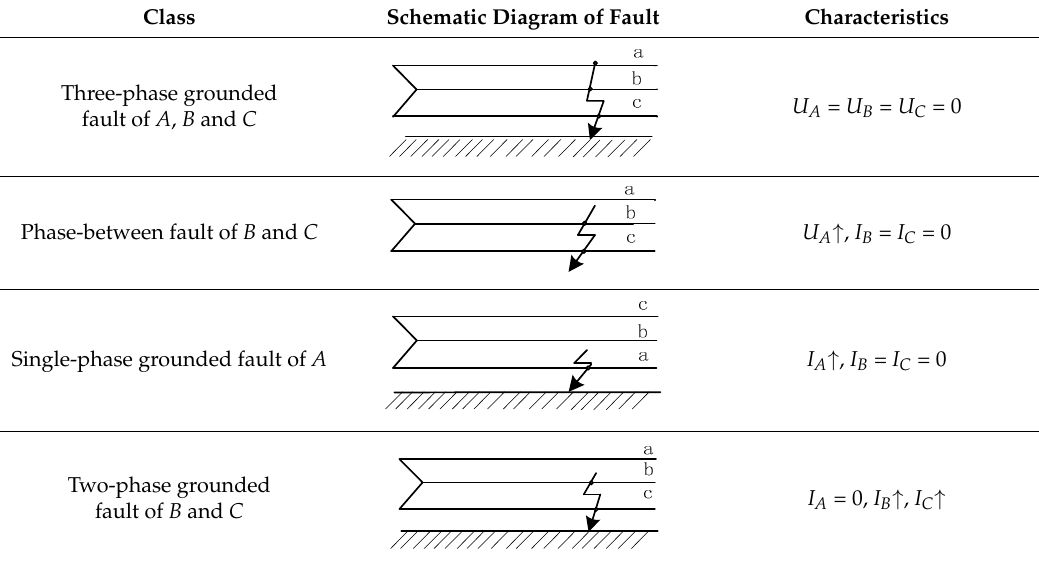
Table 1. Classes of short-circuit faults and their characteristics.